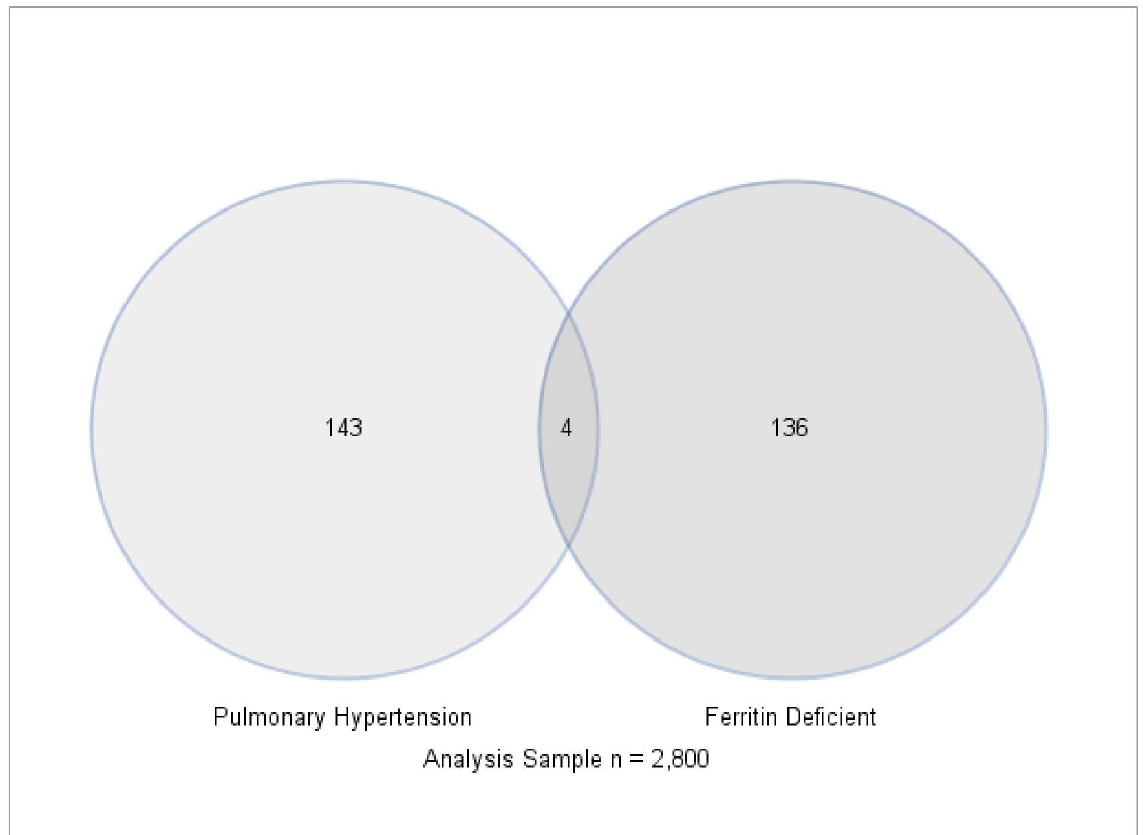
Fig 2. Venn diagram of pulmonary hypertension (n = 147) and iron deficiency based on low ferritin levels (n = 140) in the Jackson Heart Study cohort. Only 4 participants had both iron deficiencyand